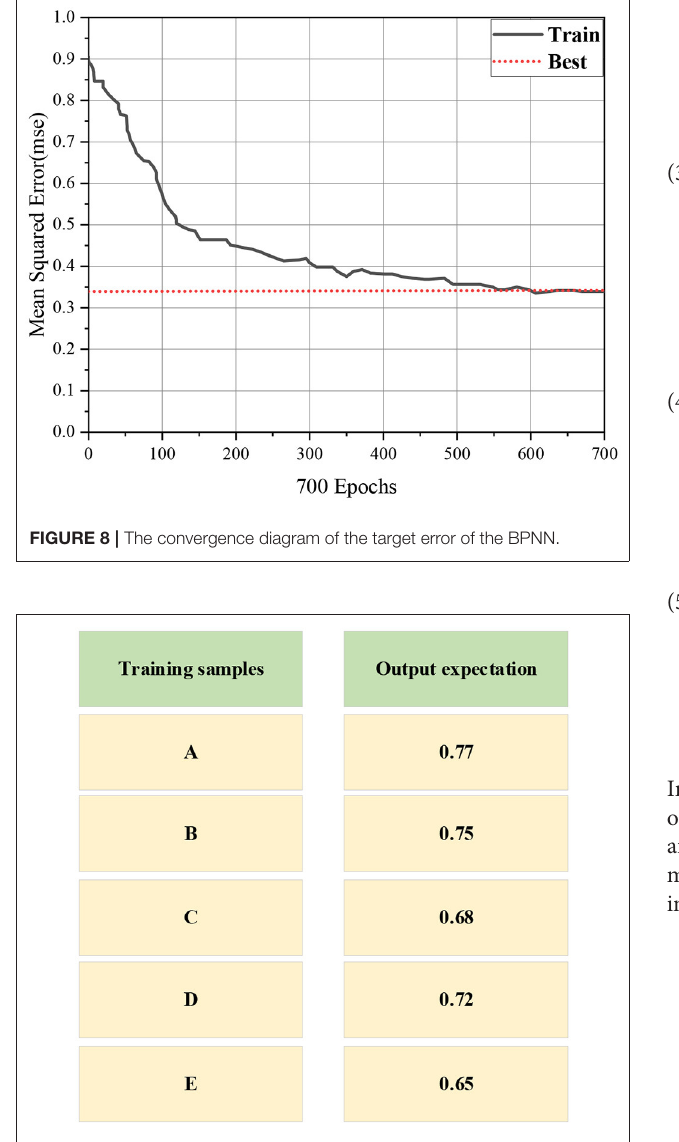
FIGURE 9 | Results of the